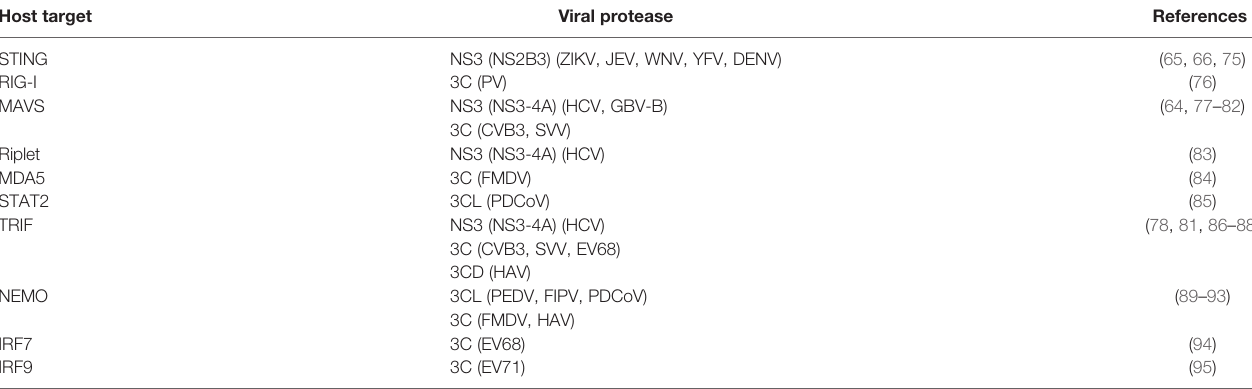
FIGURE 5 | Protease antagonism of IFN induction and signaling pathways. (A) Examples of viral proteases that antagonize the innate antiviral immune response, including antagonism of IFN-induction (left) or signaling downstream of IFN (right). (B) Model for how protease sequence speci fi city may be driven to evolve by con fl icts with host factors. Following host evolution, or cross-species transmission, viral proteases may no longer be able to antagonize a given host factor. To re- establish host antagonism, the protease can evolve to cut a different sequence at same host site (left) or may evolve to cut a new site elsewhere in the host protein (right). (C, D) Evolution of MAVS (64) (C) and STING (65) (D) across primates and other mammals confers resistance or susceptibility to fl aviviral protease cleavage. Red asterisks mark the inferred branch in which an amino acid change occurred that alters cleavage susceptibility. (E) Human STING cleavage by fl avivirus NS3 proteases is virus species-speci fi c. Data adapted from (66). TABLE 2 | Select list of IFN pathway-related targets of (+)ssRNA virus